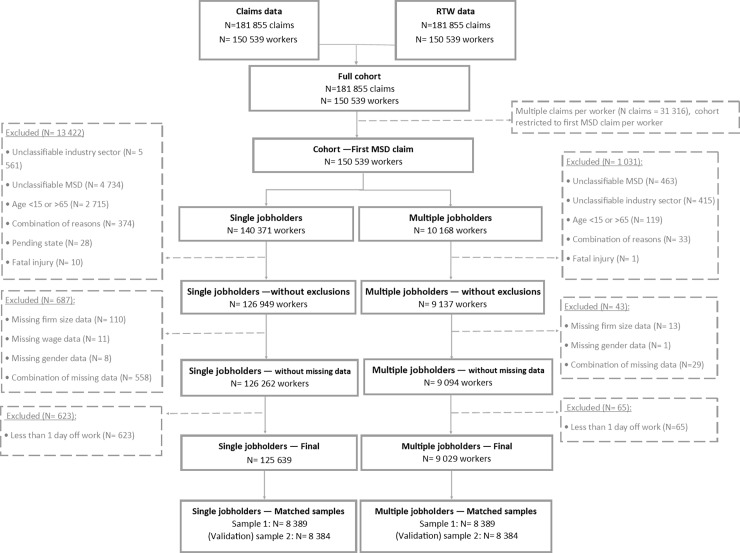
Flow chart, 2010–2014 study cohort.